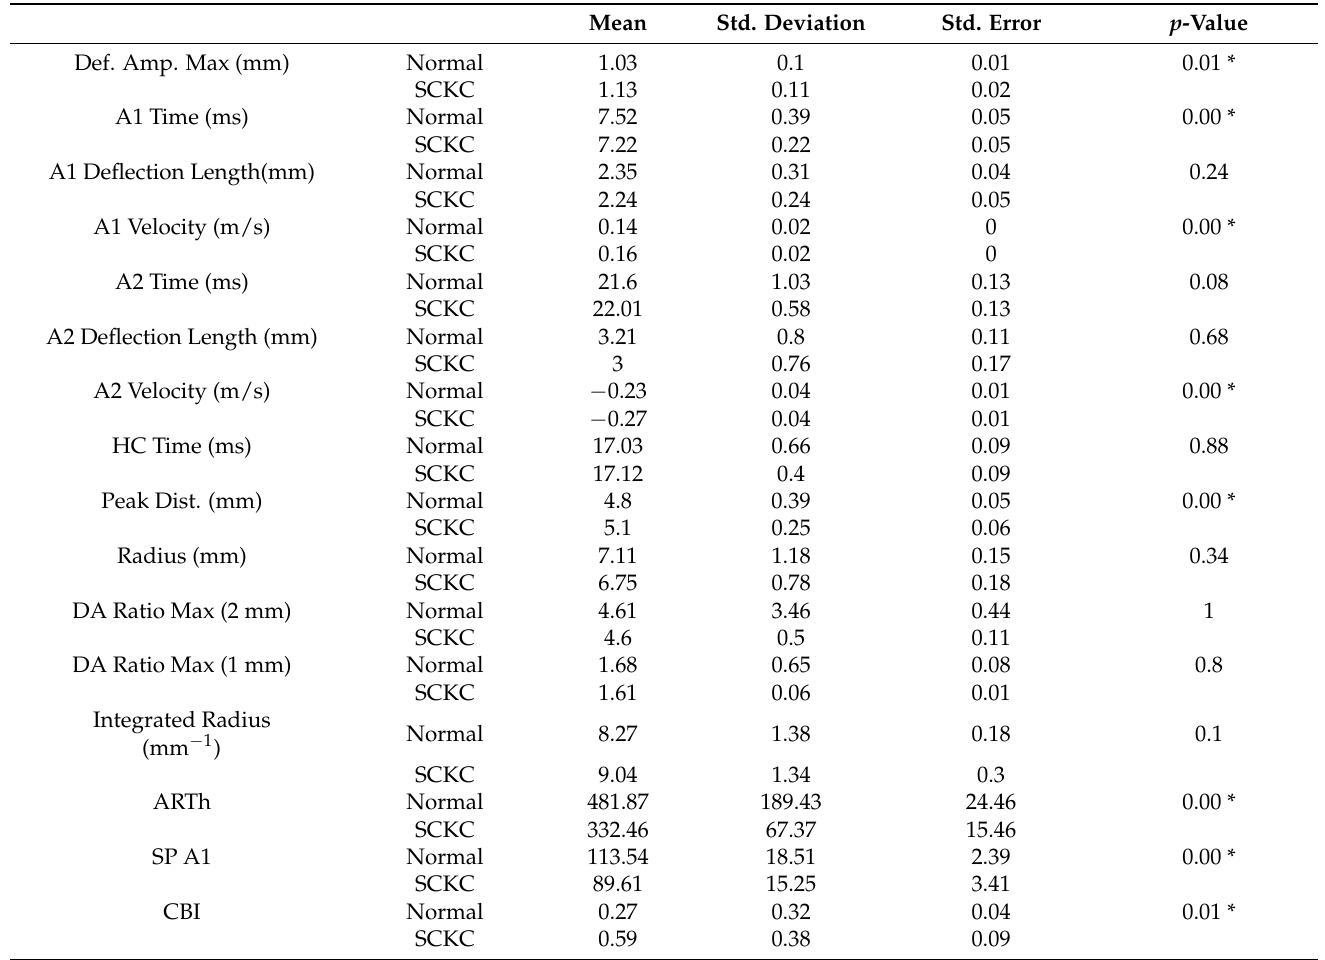
Table 2. Corvis corneal biomechanical